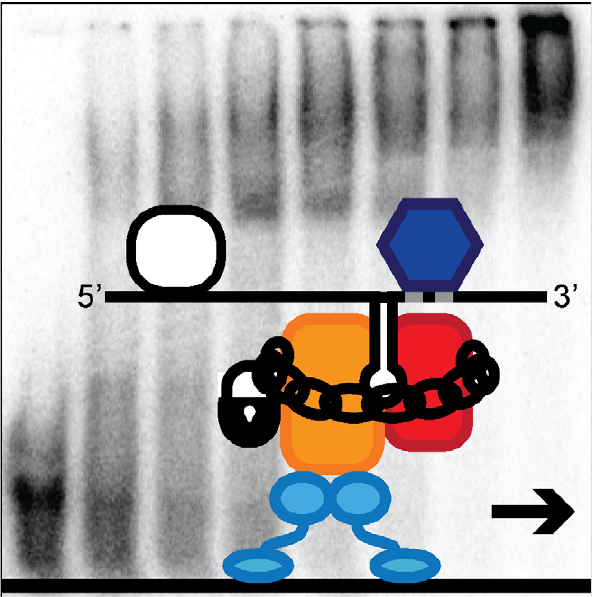
to provide non-experts with insight into the significance of the published